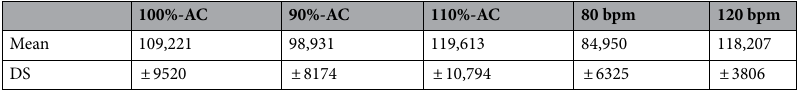
Table 3. Means and standard deviations of the group cadences for each experimental